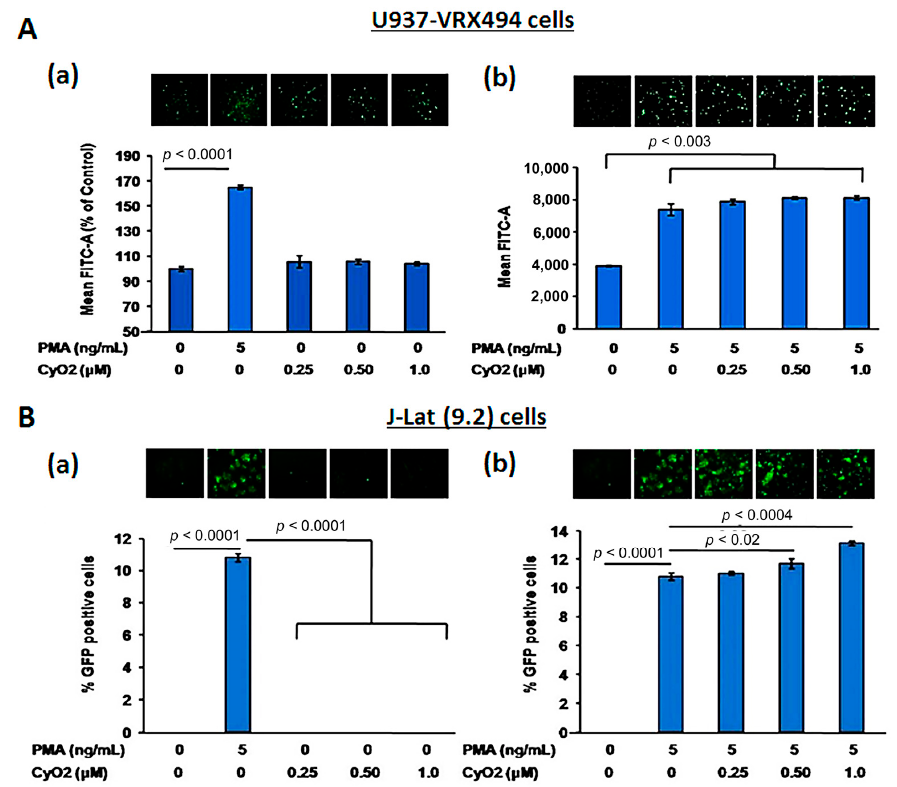
Figure 5. Effect of CyO2 on HIV-1 LTR function under unstimulated and PMA-stimulated conditions. In ( A ), the effect of CyO2 (0.25–1.0 µ M) on HIV-1 LTR directed GFP expression from U937-VRX cells are shown. Top panels show a representative image of GFP expressing cells and bottom panels show percent change in mean fluorescence (FITC-A). In ( B ), the effect of CyO2 (0.25–1.0 µ M) on HIV-1 LTR directed GFP expression from J-Lat (9.2) cells are shown. Top panels show a representative image of GFP expressing J-Lat (9.2) cells and the percent change in GFP-positive cells is shown in the bar graphs. Error bars show +/-SEM of two independent experiments in triplicate samples. Significant changes from controls are shown as P-values (*, p < 0.05). CyO2 did not alter HIV-1 LTR function in either U937-VRX (pro-monocytic) or J-Lat (9.2) (T-lymphocytic) cell lines. 3.6. CyO2 Suppresses the Infectivity of Viral Particles The envelopes of HIV-1 particles are enriched with lipid raft constituents [15,43,51], which may be preferentially targeted by CyO2. To investigate this novel phenomenon, the direct effect of CyO2 on infectious viral particles was measured (Figure 6 A–D). Initial studies were carried out using an attenuated HIV-1 based virus-like-particle (VLP) that enables direct measurement of infected cells by GFP microscopy and flow cytometry (Figure 6A). For these studies, VLPs were pre-exposed to CyO2